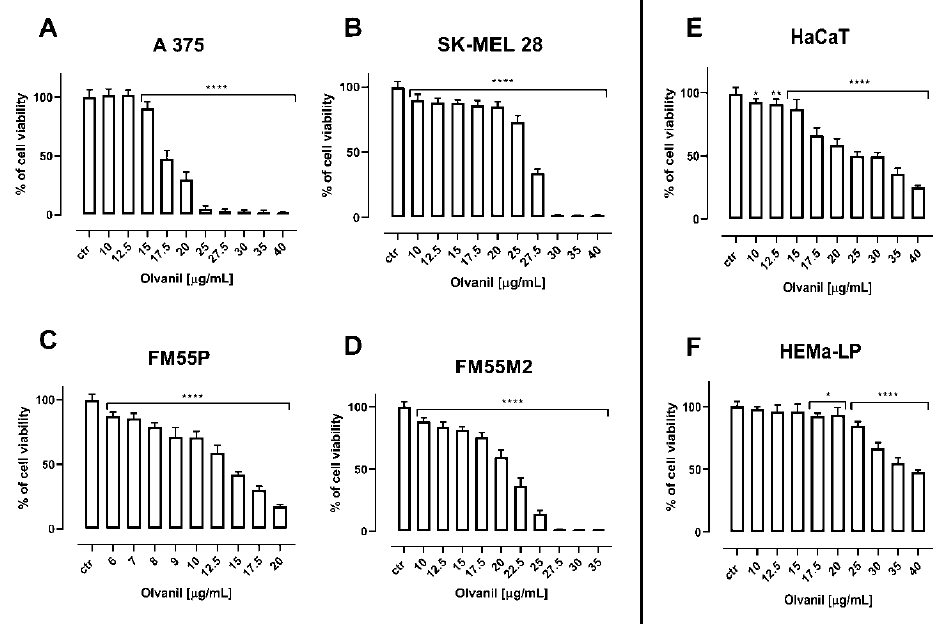
Figure 3. The impact of olvanil on the viability of malignant melanoma cell lines [A375 ( A ), SK–MEL 28 ( B ), FM55P ( C ) and FM55M2 ( D )], normal human keratinocytes [HaCaT] ( E ), and normal human melanocytes [HEMa–LP] ( F ), measured by means of MTT assay. Columns represent mean ± SEM (* p < 0.05, ** p < 0.01, and **** p < 0.0001).